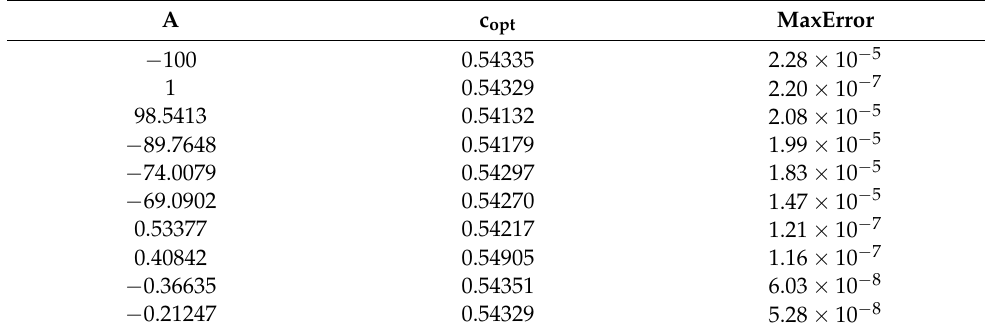
Table 4. Partial results of A ∈ [ − 100,100 ] or A ∈ [ − 1,1 ]